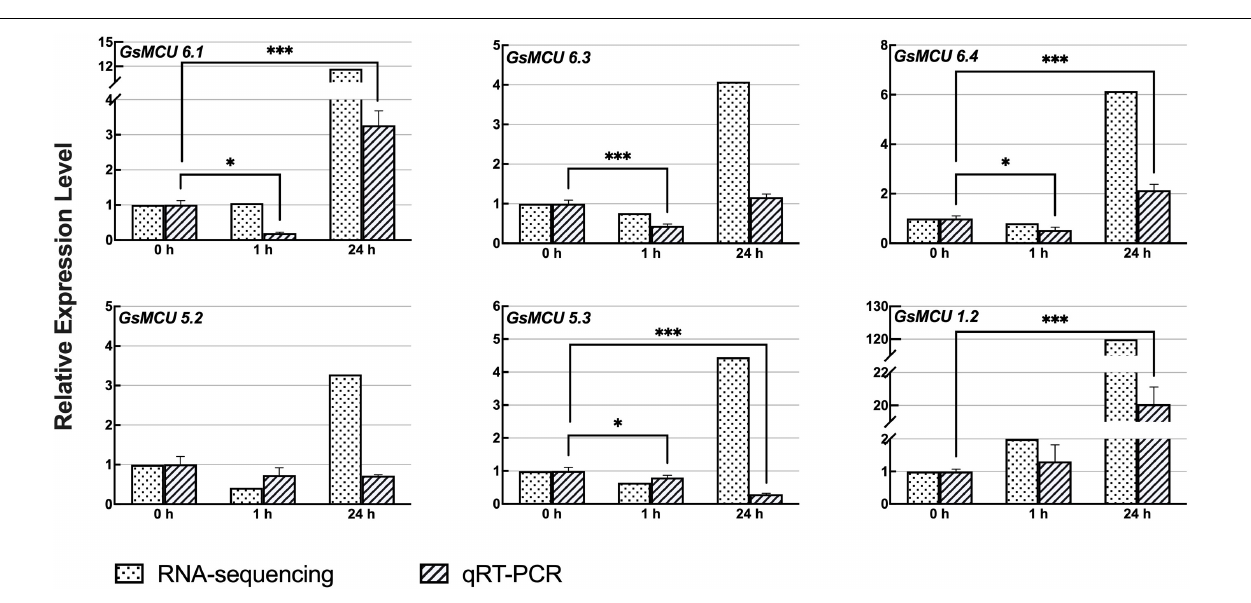
FIGURE 7 | Expression analyses of wild soybean MCU family genes under cold stress. To induce cold stress, 2-week-old wild soybean seedlings were treated at 4 ◦ C for 0, 1, and 24 h. GlysoPI483463.12G046600 was used as an internal reference. Mean values ( ± SE) of the three fully independent biological repeats and three technical repeats are shown. Asterisks indicate significant differences ( ∗ p < 0.05, ∗∗∗ p < 0.001 using Student’s t